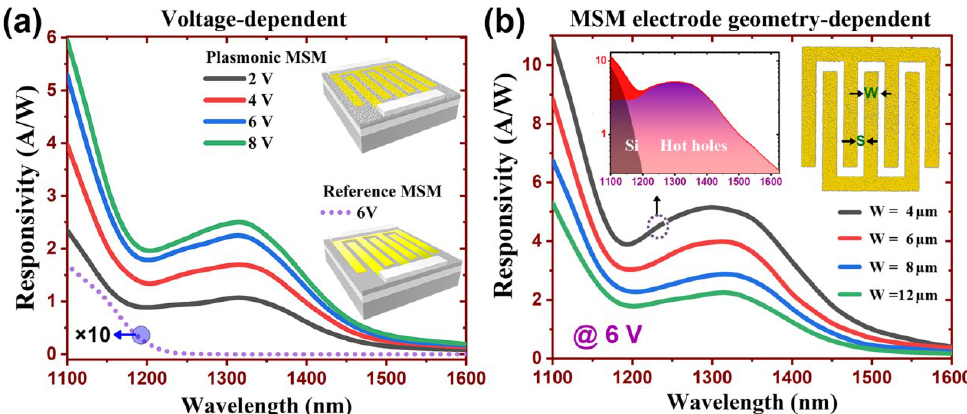
Figure 5. The measured spectral photocurrent responsivity of the plasmonic and planar MSM photoconductors. ( a ) Voltage-dependent responsivities for the device with a fixed electrode finger width (D4, W = 12 μm). ( b ) The measured responsivities for devices with four different electrode geometries.